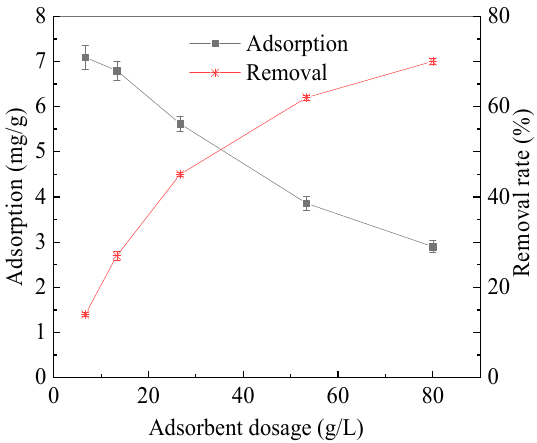
Figure 1 . Absorption and removal rate with the adsorbent dosage changes. Figure 1. Absorption and removal rate with the adsorbent dosage